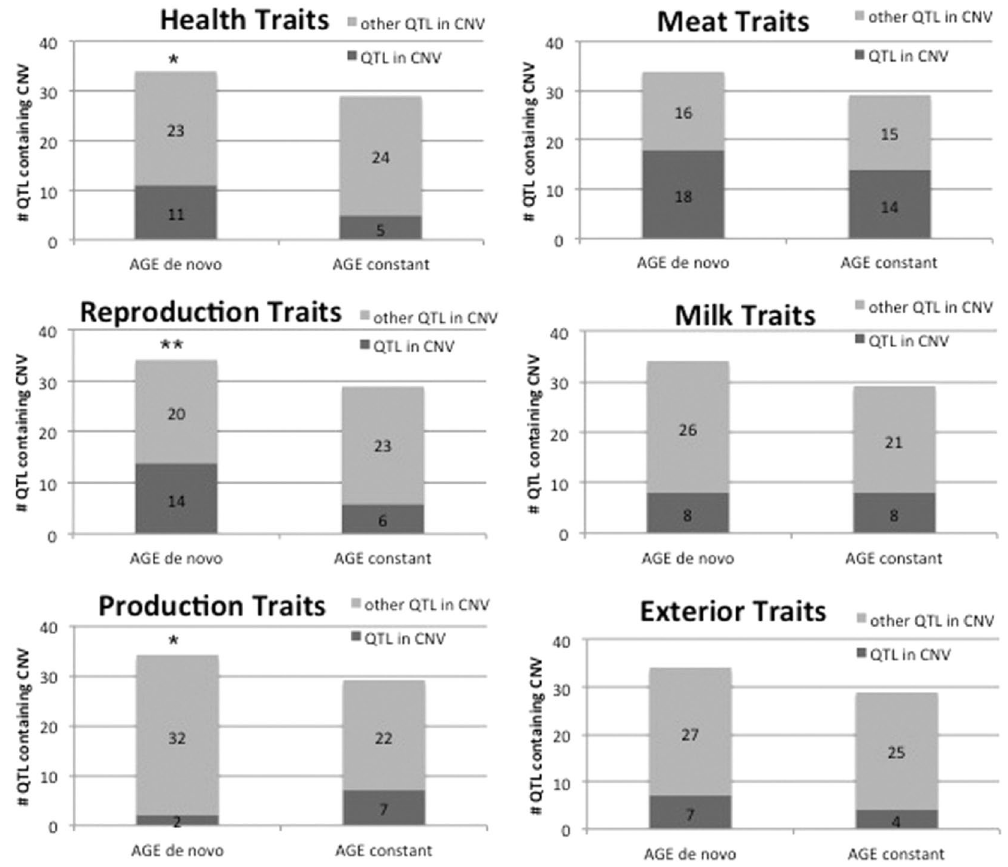
Figure 3. Number of major QTL classes assigned to the in vivo AGE CNVs. * p < 0.05, ** p <